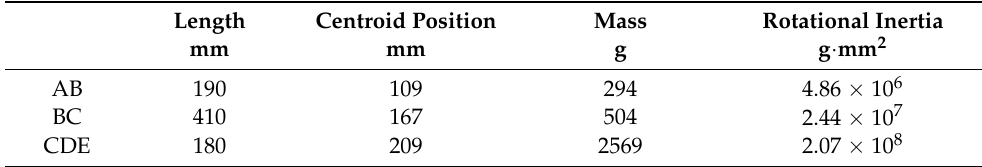
Table A1. Geometric parameters for kinematic and dynamic